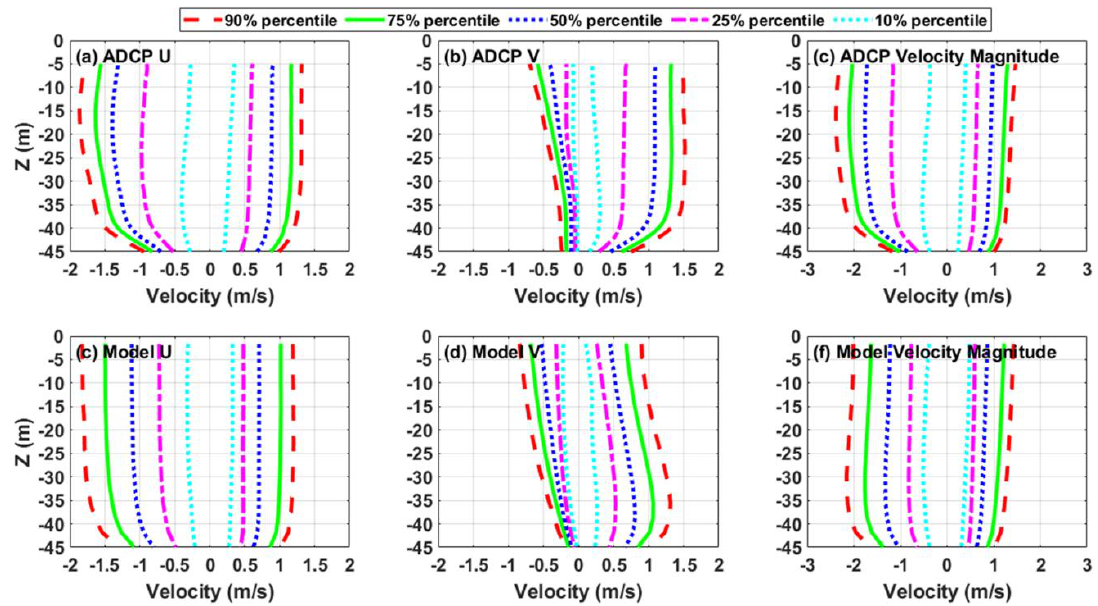
Figure 7. Comparison of the observed and modeled vertical profiles of velocity percentiles at station WP1 in the Western Passage based on three months of records: ( a , b ) the observed east (u) and north (v) velocity components; ( d , e ) the modeled east (u) and north (v) velocity components; ( c , f ) the observed and modeled velocity magnitudes, with positive as the ebb current and negative as the flood current. Velocity percentiles were calculated as 10%, 25%, 50%, 75%, and 90%.